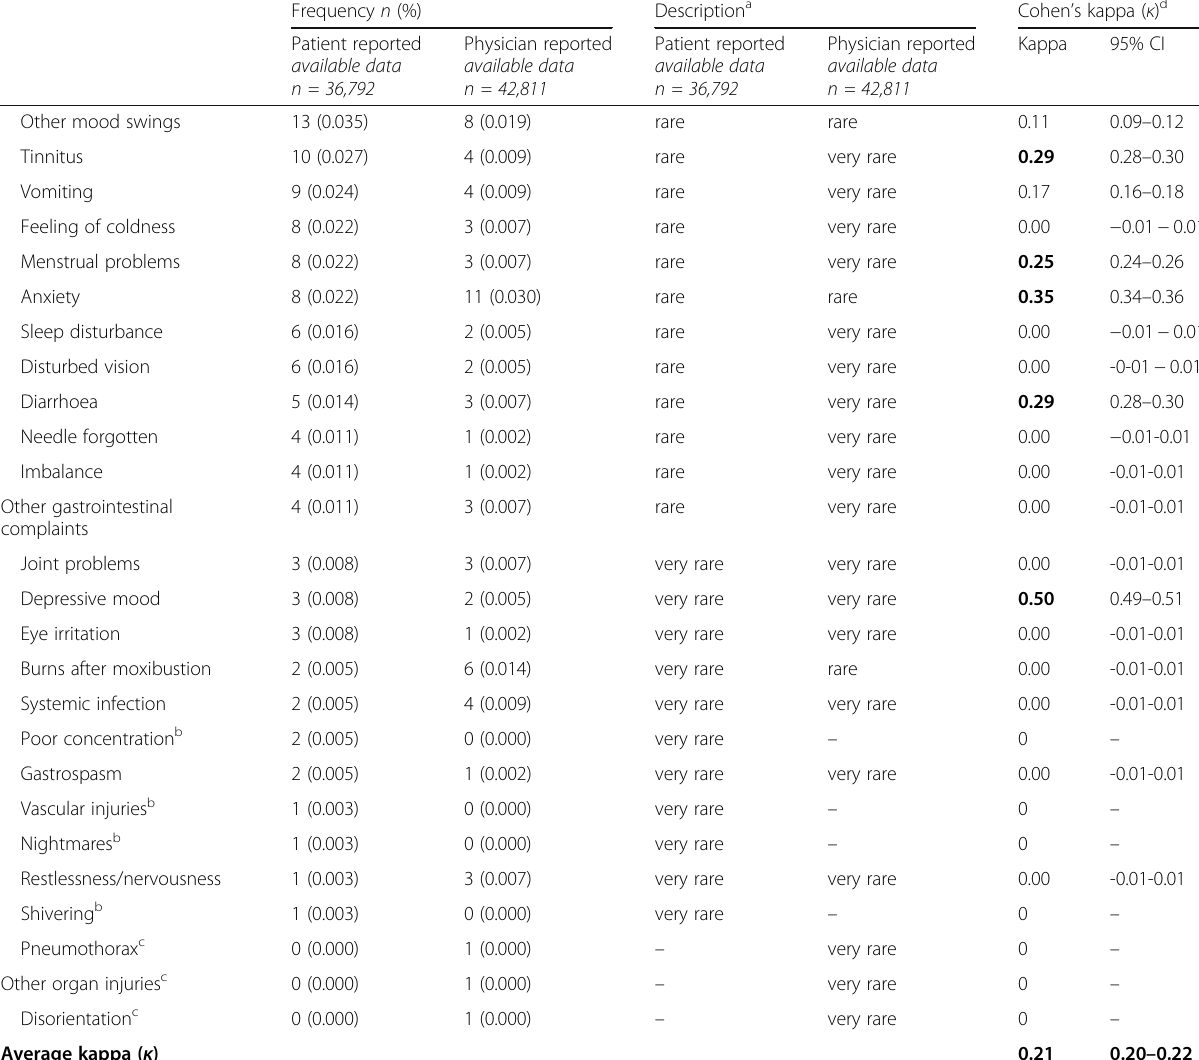
Table 2 Frequency of reported adverse reactions by patients and physicians sorted by categories in frequencies and proportions, description in text form, and agreement as Cohen ’ s kappa ( κ ) coefficient with 95% confidence interval (CI) for 36,792 and 42,811 available data of 44,818 patients